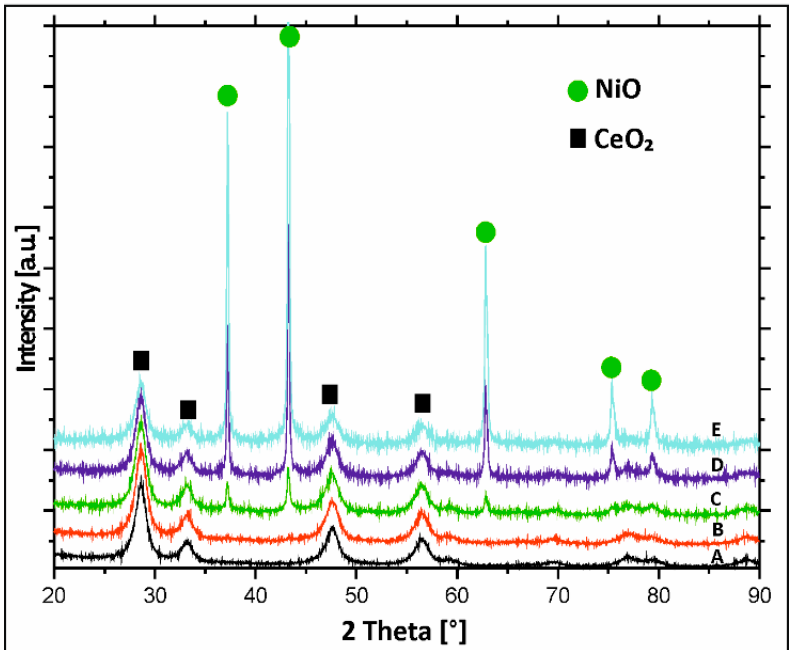
Figure 3. X-ray powder patterns of calcined ( A ) binary oxide and monometallic; ( B ) 5%Ni/CeO 2 –Al 2 O 3 ; ( C ) 20%Ni/CeO 2 –Al 2 O 3 ; ( D ) 40%Ni/CeO 2 –Al 2 O 3 ; and ( E ) 60%Ni/CeO 2 –Al 2 O 3 catalysts in an air atmosphere for 4h at a temperature of 400 °C.